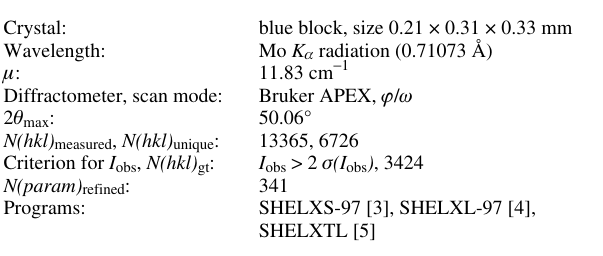
Table 1. Data collection and handling.